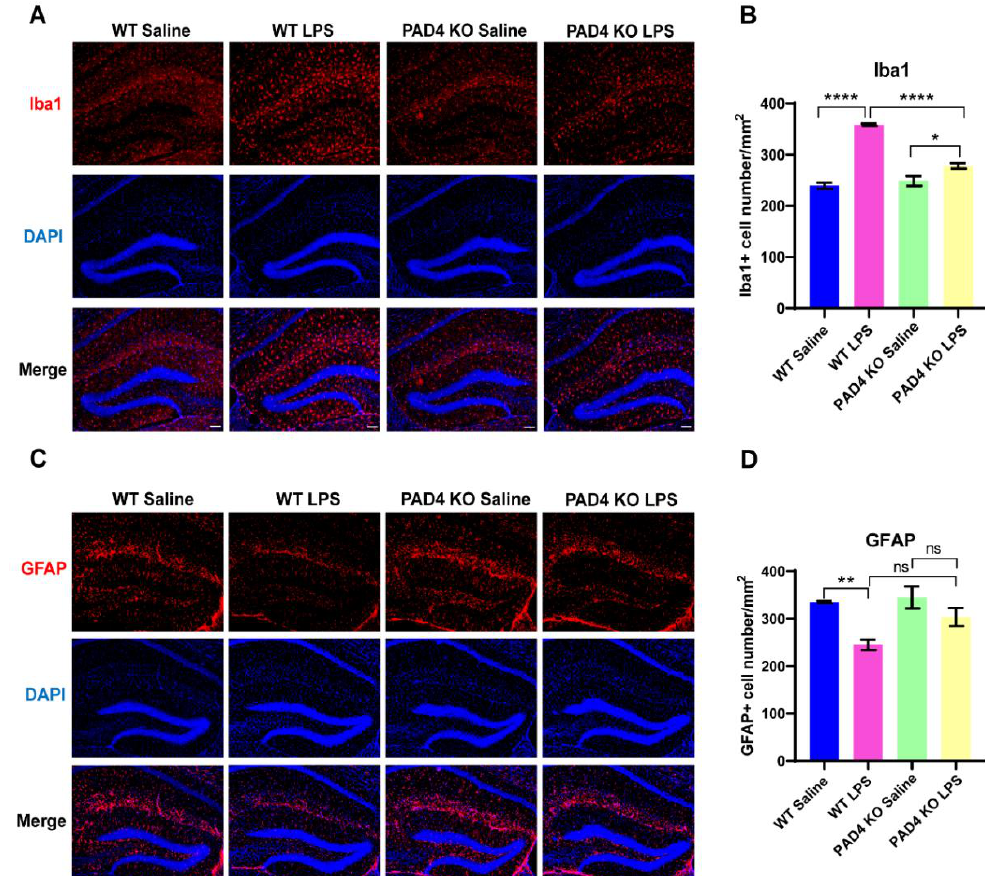
Figure 5. The influence of LPS on glia cells among the PAD4 KO and wildtype mice. ( A ) Representative immunofluorescence of Iba-1 in the hippocampus. ( B ) Column graphs representing Iba-1 expression. ( C ) Representative immunofluorescence of GFAP in the hippocampus. ( D ) Column graphs representing GFAP expression. Data were expressed mean ± SEM. * p < 0.05, ** p < 0.01, **** p <0.0001. bar = 100 um; WT Saline, WT LPS, PAD4 KO Saline: n = 3; PAD4 KO LPS: n = 4 .